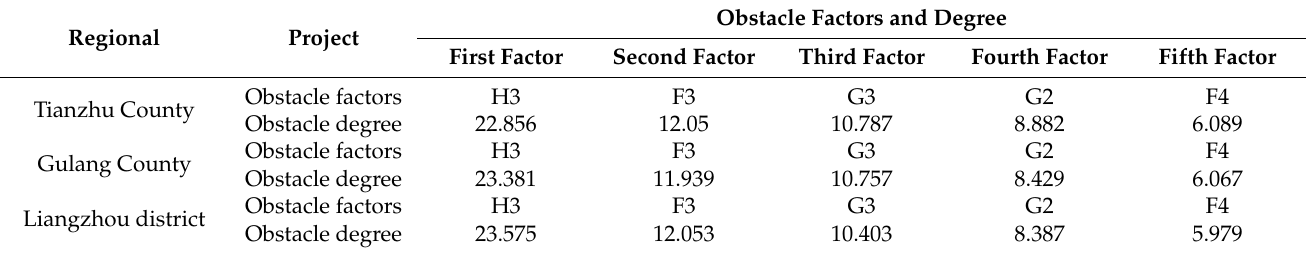
Table 5. The top five obstacle factors and degree in